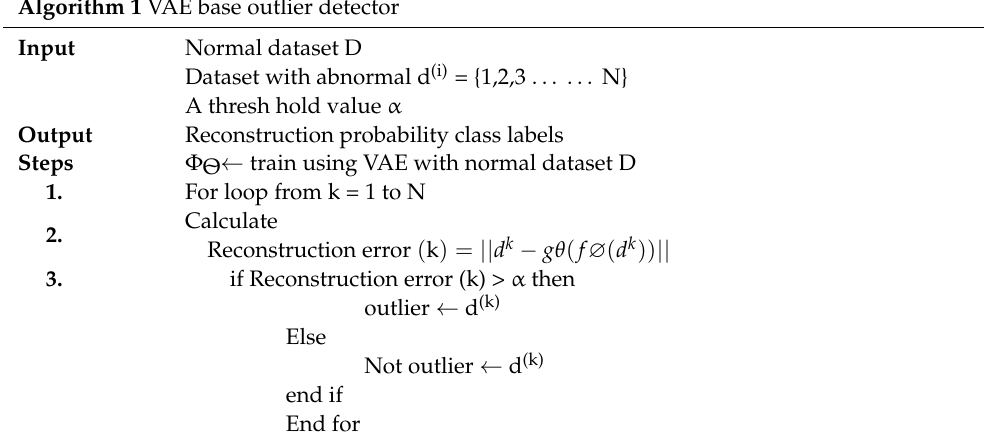
Algorithm 1 VAE base outlier detector